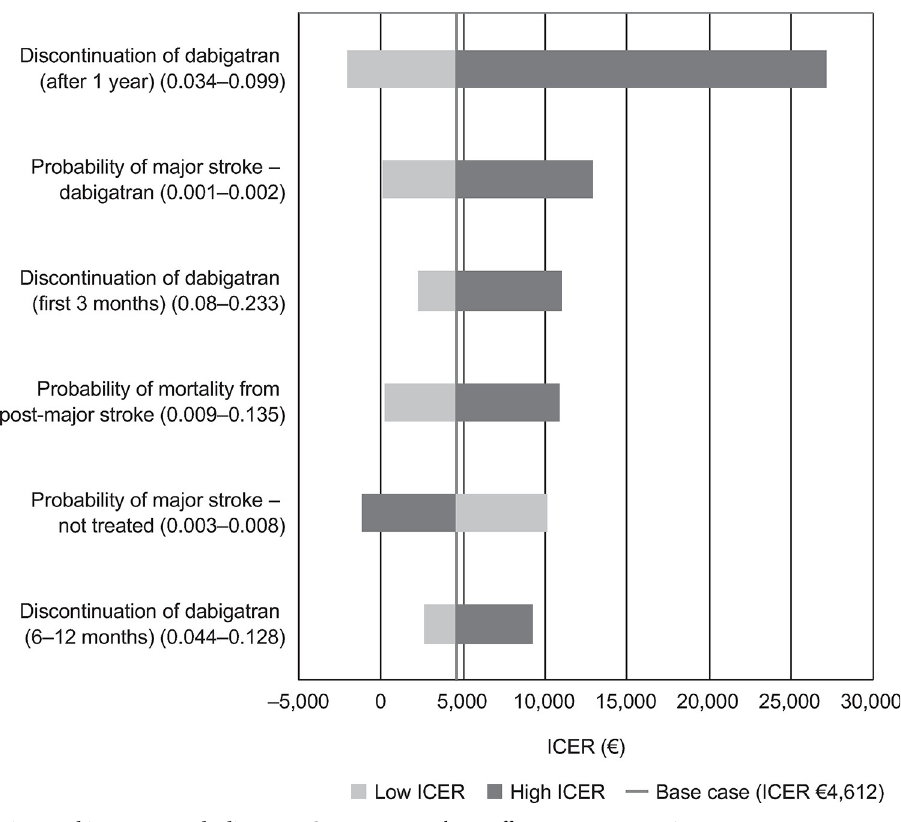
Fig 2. Dabigatran tornado diagram. ICER, incremental cost-effectiveness ratio; VKA, vitamin K antagonist.